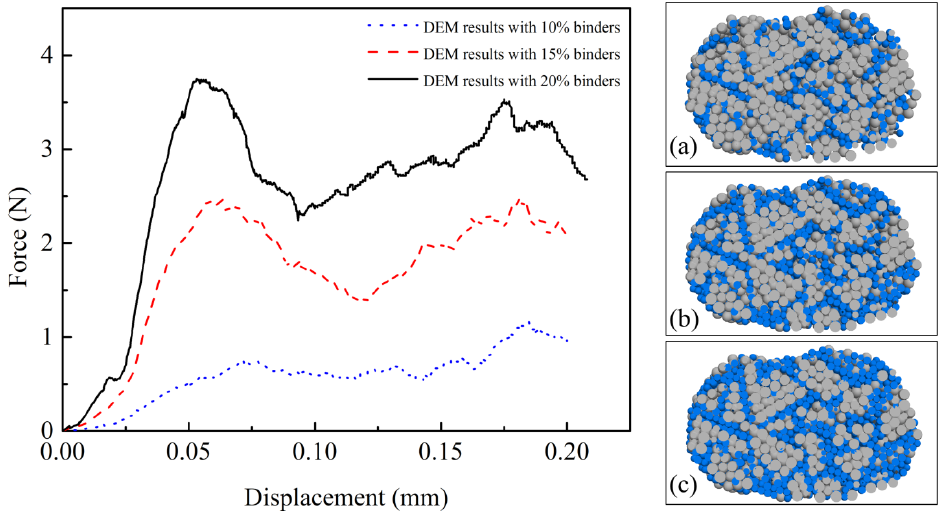
Figure 11. Force–displacement curve of the composite particle with varying binder content: ( a ) 10% binder; ( b ) 15% binder; ( c ) 20%